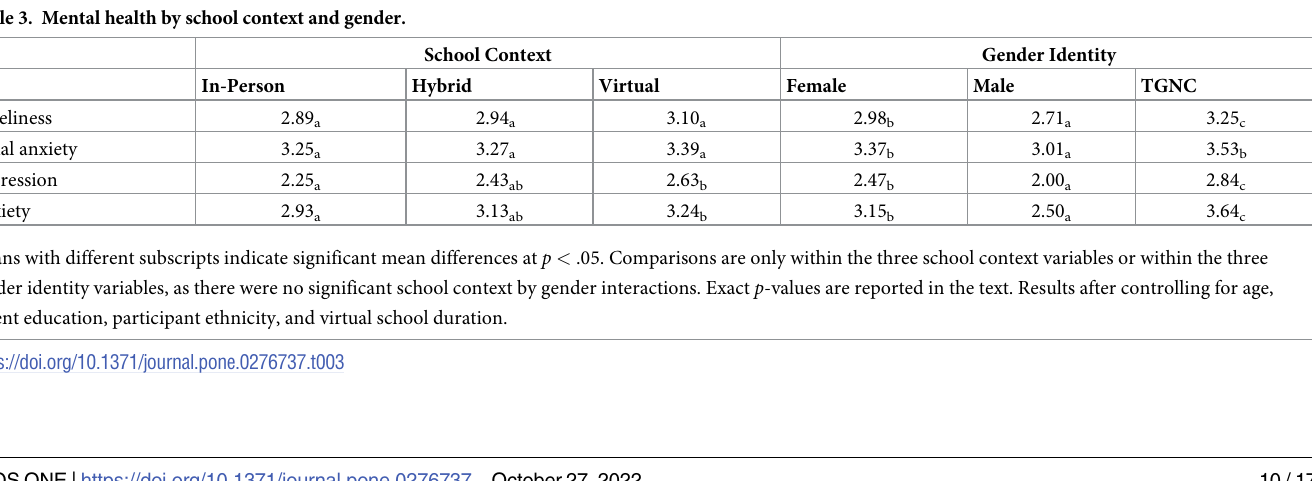
Table 3. Mental health by school context and gender.